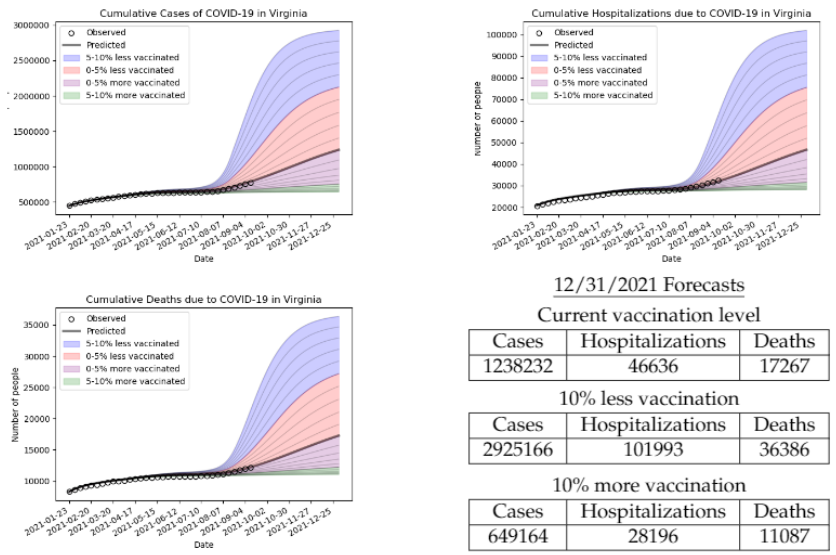
Figure 4. Simulations of the two-stage vaccination model (1) with parameters from Table 2 and differing values of overall vaccine uptake ( M 1 and M 2 ). The transmission rate during the period September 18 through 31 December 2021 is assumed to be that of the final fit period (i.e., β ( t ) = β 8 = 0.453). In the bottom right, forecast values through 31 December 2021 are shown for cumulative cases ( C ), hospitalizations ( H ), and deaths ( D ) given current vaccination uptake, 10% more vaccination, and 10% less vaccination.